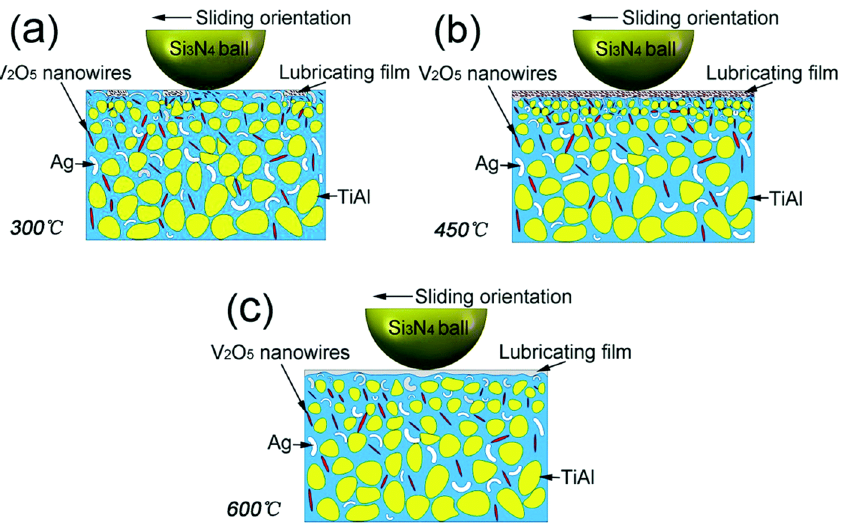
Figure 6. Wear mechanism of TiAl–5 Ag–1.5 V 2 O 5 ( a ) 300 °C, ( b ) 450 °C, ( c ) 600 °C. Reproduced with permission from [66]. Copyright RCS advances, 2016.